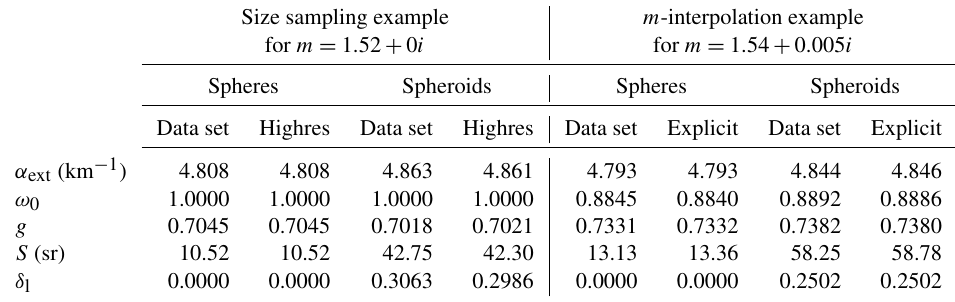
Table 3. Optical properties calculated for a lognormal mode with r mod = 0 . 5µm, σ = 2 . 0, r min = 0 . 001µm, and r max = 4µm at λ = 628 . 32nm. Two cases of particle shapes are considered: spheres and prolate spheroids with (cid:15) (cid:48) = 2 . 0. The columns “data set” contain values calculated using MOPSMAP with the data set described in Sect. 2.3. For comparison, the same properties are calculated in the columns “highres” using a high size resolution and in the columns “explicit” using Mie theory or TMM explicitly at m = 1 . 54 + 0 . 005 i . Size sampling example m -interpolation example